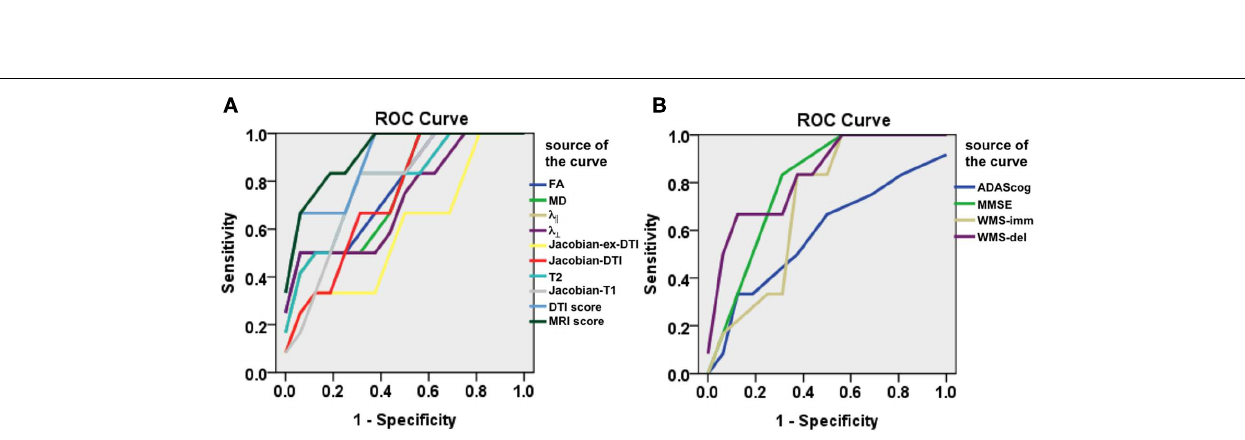
FIGURE 4 | Scattergrams of the measured DSF values of the eight parameters, the discriminant scores (DTI score and MRI score), and the results of cognitive tests of the test dataset (MCI-converter and MCI-stable) . MD, λ || , and λ ⊥ : 10 − 3 × mm 2 /s;T 2 : ms. C: aMCI-converter; S: aMCI-stable.